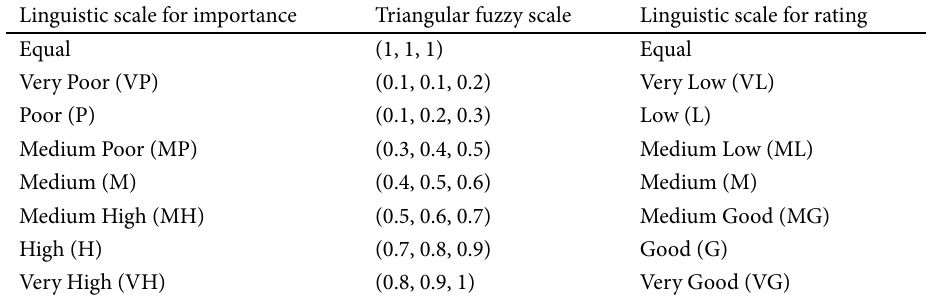
Table 2. Linguistic scales for importance and rating Linguistic scale for importance Triangular fuzzy scale Linguistic scale for